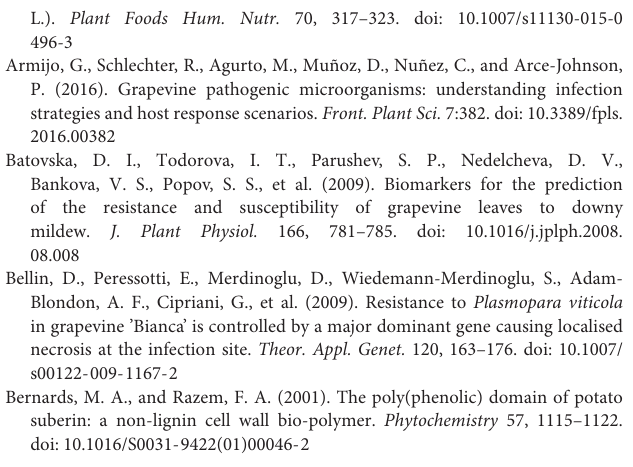
Supplementary Figure 1 | Genotypes in the greenhouse. Supplementary Figure 2 | PCA_Single genotypes and polyphenolic